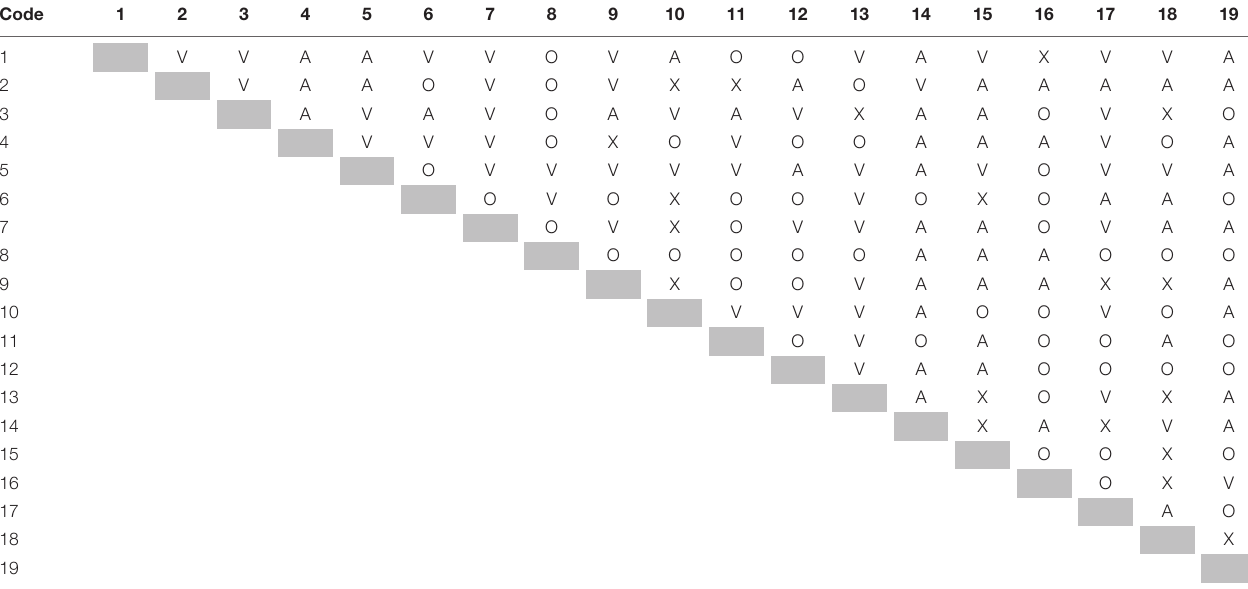
Shaded diagonal cells are ii part of the matrix that differentiates ij part of the matrix from ji. TABLE 3 | Initial reachability matrix.